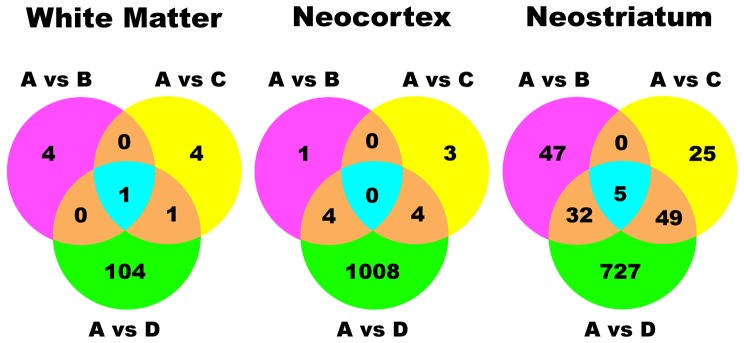
Venn diagrams of regulated probes on the array.The number of significantly regulated transcripts is shown in the three HIV-1 infected groups (Groups B, C, and D) as compared to uninfected controls (Group A) in three brain sectors. The criteria for significance employed a cutoff filter of ±2 fold change and p≤0.05 with the Benjamini-Hochberg correction for multiple testing comparisons using S+ArrayAnalyzer. Outer lobes represent probes regulated exclusively in one group. Regions within points of intersection represent probes regulated in more than one group. Group D (in green) contains NCI subjects with HIVE and had the most regulated genes in every brain sector. In neostriatum 91% of the probes with HIVE were upregulated. In neocortex 84% of the probes with HIVE were downregulated. Group C (yellow) contains NCI subjects without HIVE. Group B (purple) contains HIV-1-infected subjects without any NCI or HIVE. Groups B and C had few regulated probes that were delimited to neostriatum primarily. See Table 2 for the lists of regulated canonical pathways.